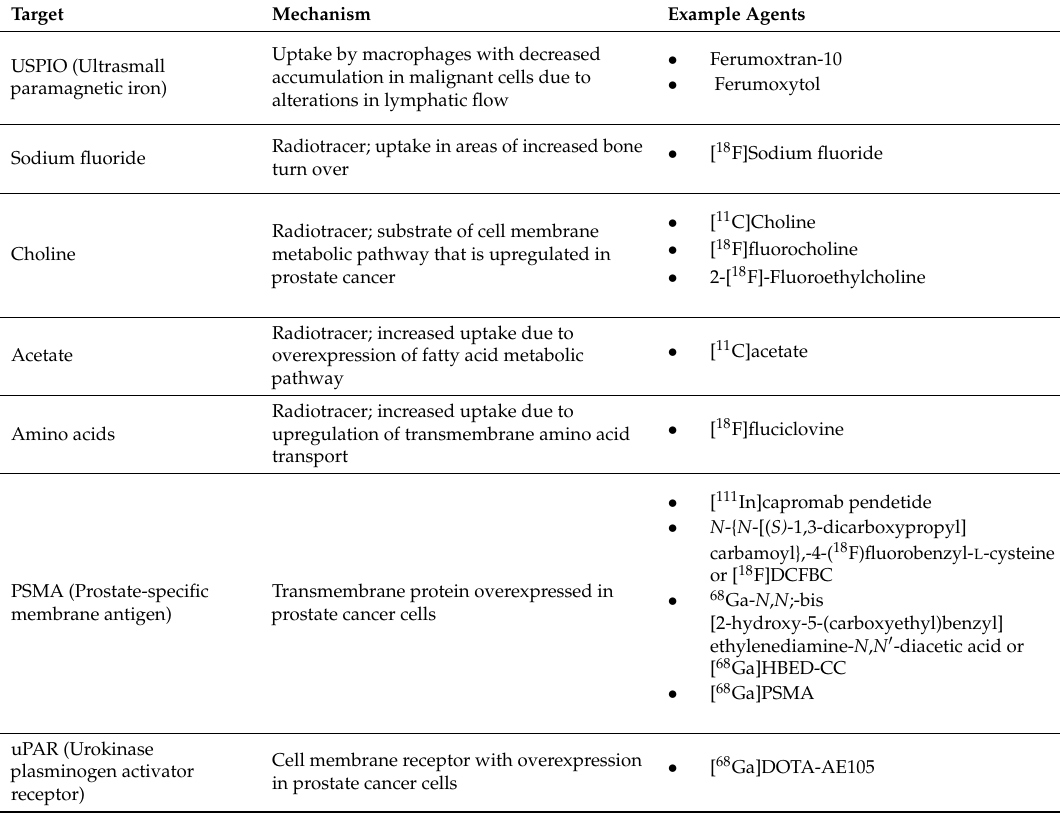
Table 1. Imaging techniques targeting prostate cancer